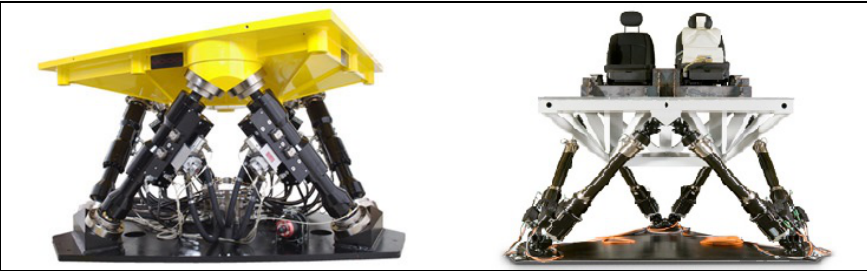
Figure 2 – Shake tables: hydraulic – left, electric – right Рис . 2 – Вибростол : гидравлический – слева ; электрический - справа